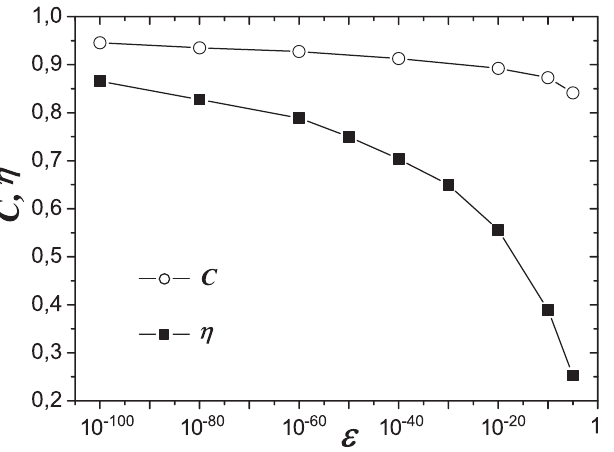
Figure 4. PHN Topology The compactness index, g , and the clustering index, C, shown here as a function of the E-value cutoff e , describe the global and local topology of the network, respectively. For growing values of e , g rapidly decreases towards 0, while C always has values well above 0.8. These results indicate that the PHN is formed by compact regions that are loosely connected to form globally sparse connected